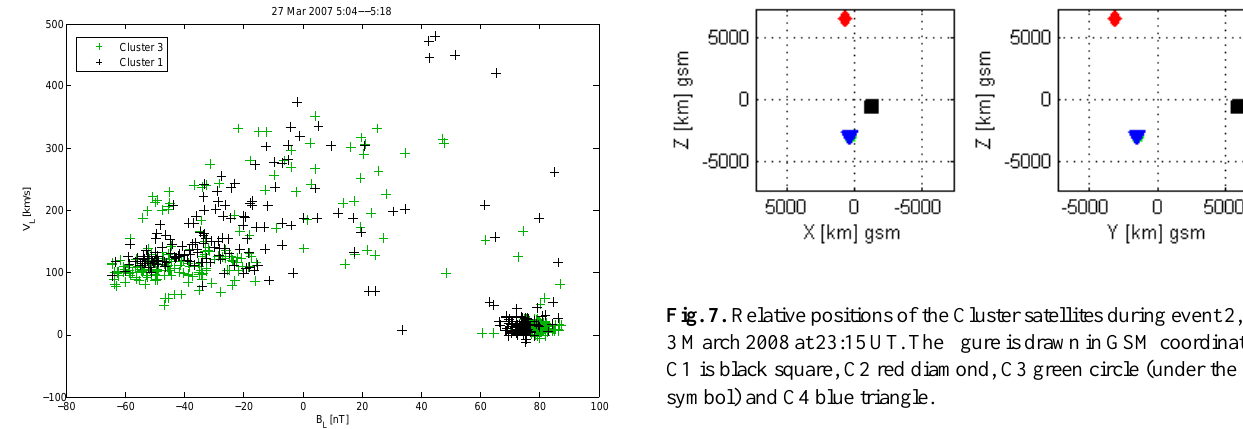
Fig. 5. Wal´en test for the outbound magnetopause crossing immediately after the observation of the fast jet in Fig. 4. The insert shows a sample ion distribution function during the fast jet: The D-shaped jet population, advancing parallel to the magnetic field, has a lower cutoff at the HT frame speed.